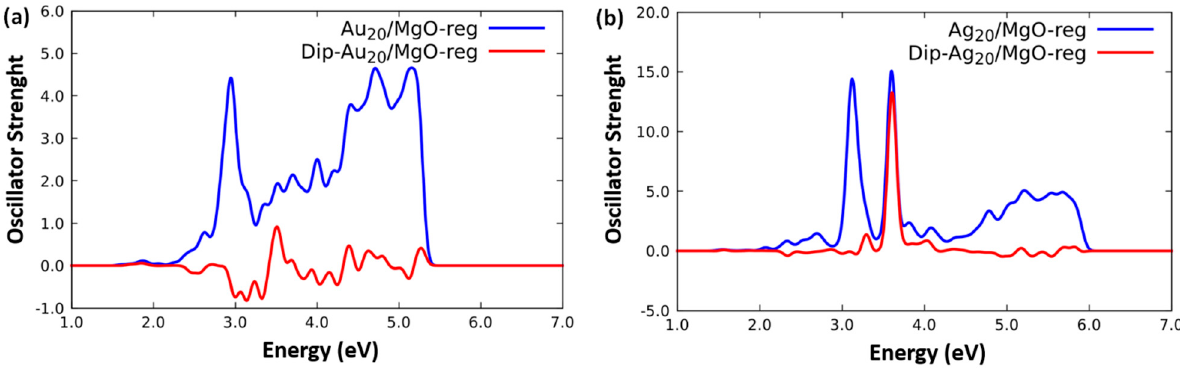
Figure 4. Blue curves: simulated TDDFT/PBE0 photo-absorption spectra of: ( a ) Au 20 /MgO(100)-reg and ( b ) Ag 20 /MgO(100)-reg using ORCA code. Red curves: signed contribution to the oscillator strengths associated with the perpendicular component of the transition dipole moment.